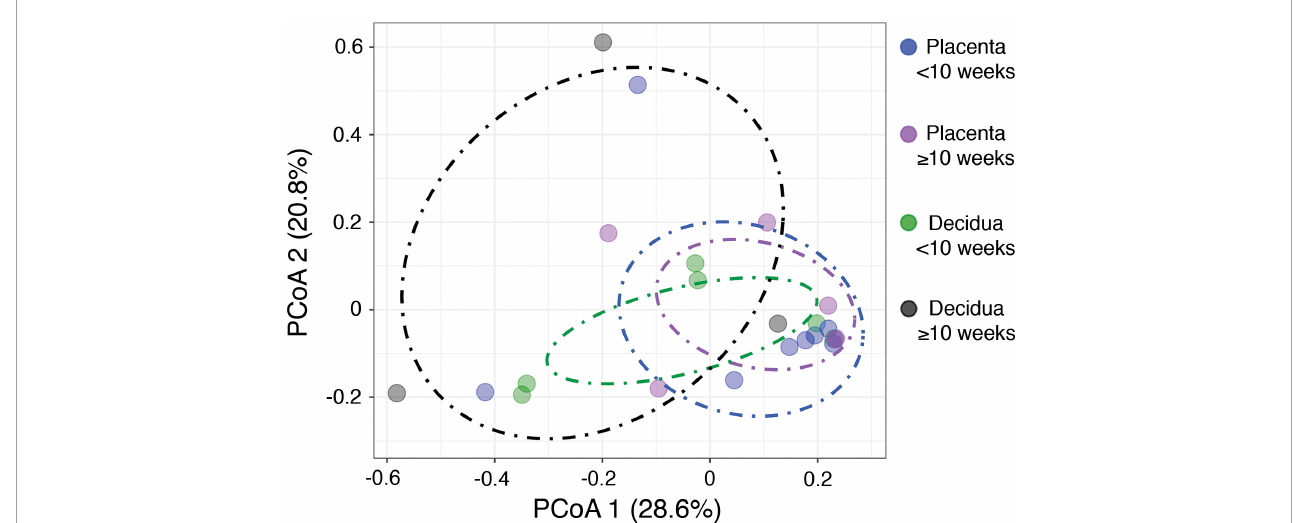
FIGURE3 Beta diversity between placental and decidual samples before and after 10 weeks gestational age.